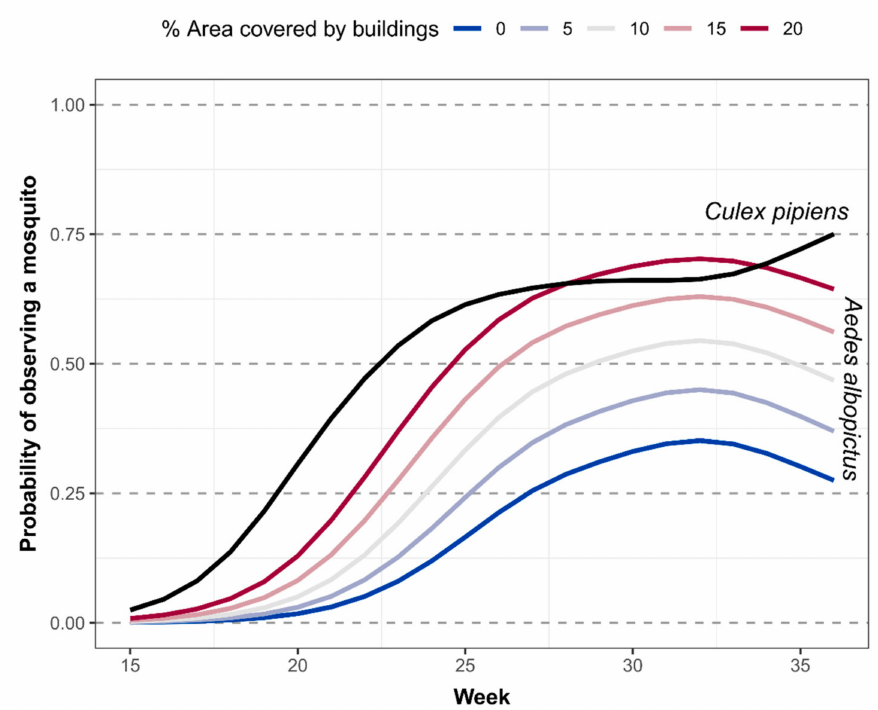
Figure 3. Detection probability of mosquitoes in the 0–1 range. The x-axis shows the week, and the y-axis shows the probability of observing at least one mosquito. The black solid line represents the detection probability of Culex pipiens , which is not statistically associated with the percentage of area covered by buildings. The colored solid lines represent the detection probability of Aedes albopictus conditional on the percentage of area covered by